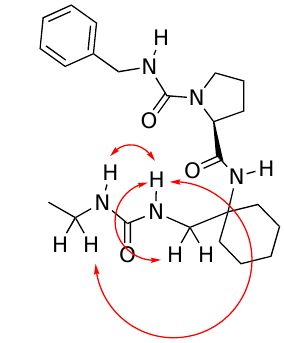
Figure 9. Summary of NOE of compound 3 at +25 °C, t-mix = 600 ms (CDCl 3 , 500 MHz).